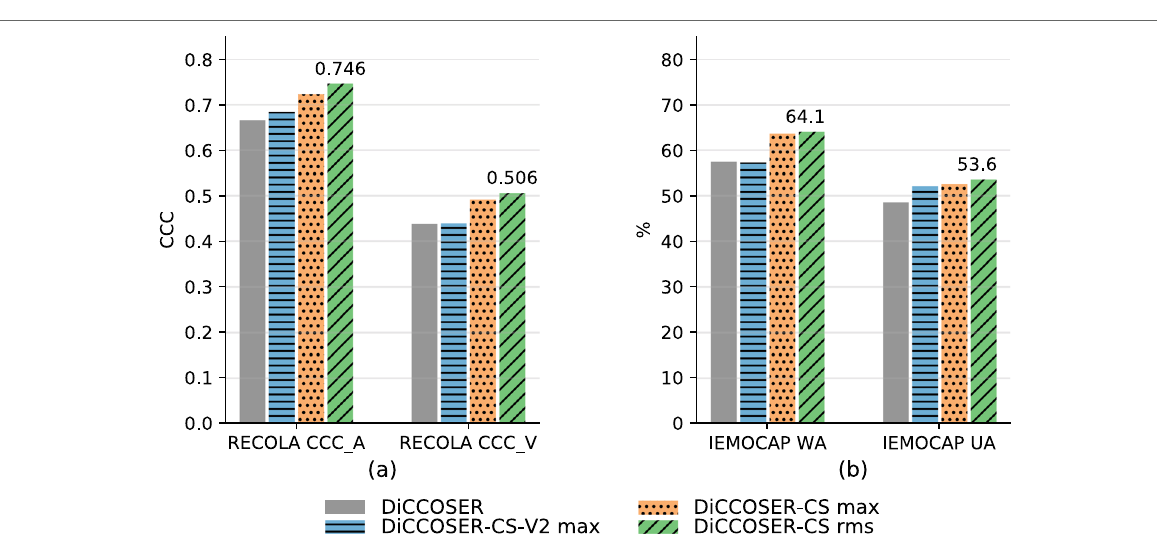
Fig. 5 Performances of four proposed model variations on a the RECOLA dataset and b the IEMOCAP dataset. Suffix “-CS” indicates using the context stacking; “max” and “rms” indicate using the max-pooling aggregation and the RMS aggregation,